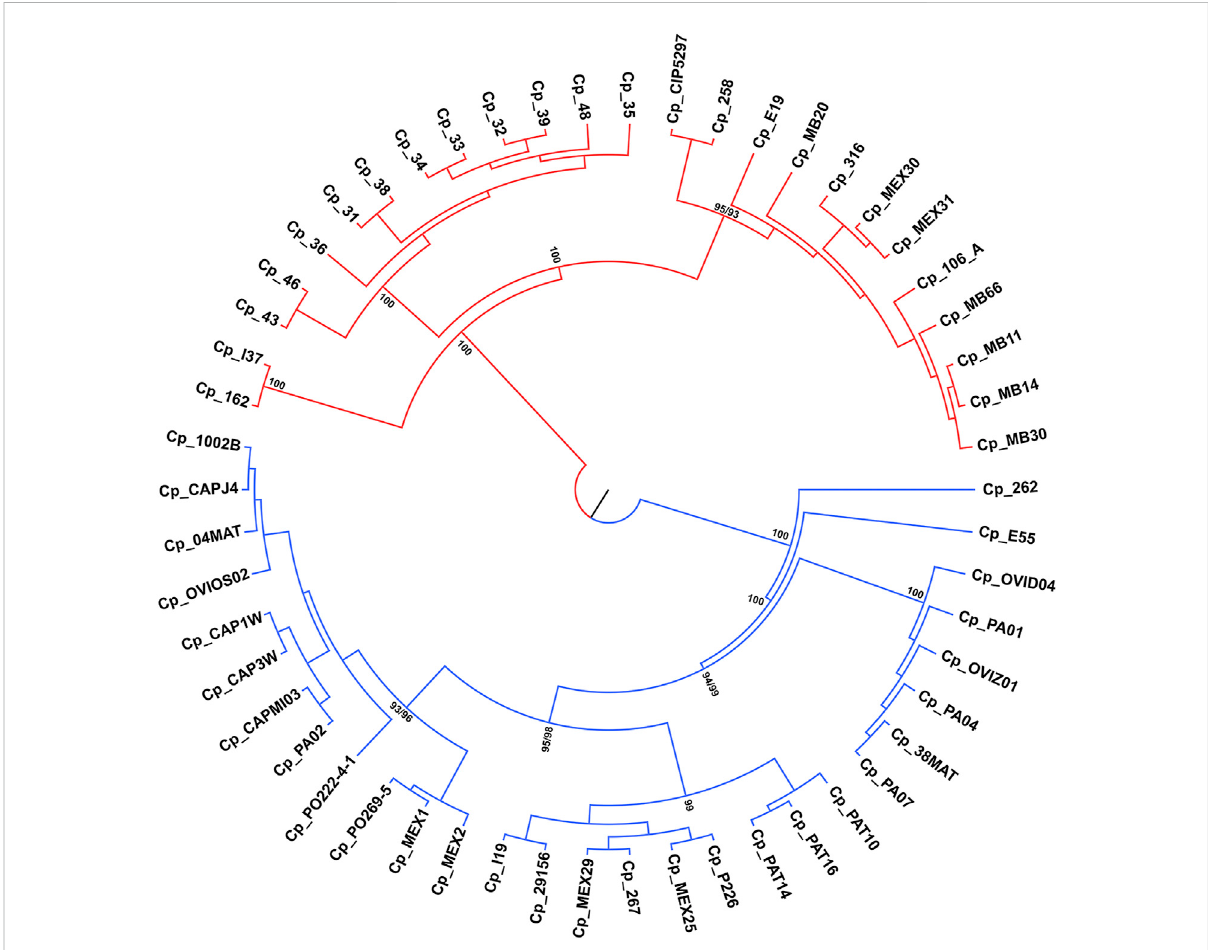
FIGURE 5 Phylogenetictreereconstructionofthe54genomesof C.pseudotuberculosis ,branchingintotwomaincladeswithmaximumbootstrapvalues for the ovis (in blue) and equi (in red)